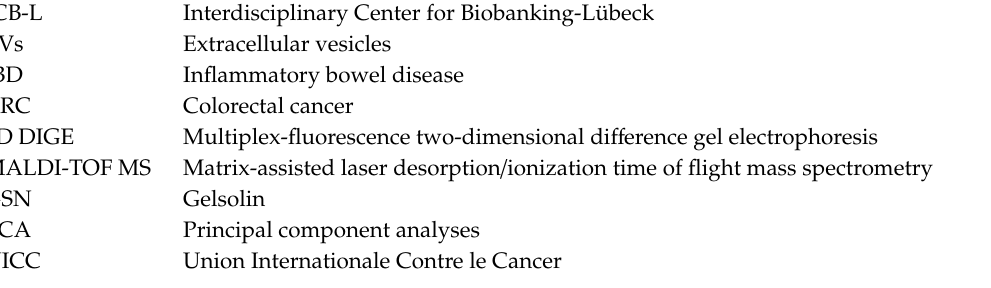
Supplementary Table S1: Patient cohort for 2D-DIGE protein profiling of extracellular vesicles, Supplementary Figure S2: Representative 2-DIGE protein profiles of serum-derived EVs and corresponding supernatants, Supplementary Figure S3: Hierarchical cluster analysis of 936 protein spots visualized with dendrograms for both ultracentrifugation and ExoQuick ™ , Supplementary Figure S4: Western blot validation of Gelsolin in EVs isolated with ultracentrifugation and ExoQuick ™